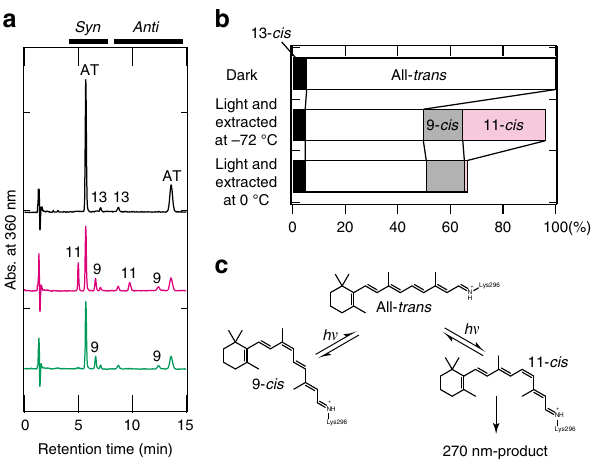
Fig. 2 Retinal con fi gurations in the intermediates produced by irradiation of Opn5L1 at − 72 °C. a HPLC patterns of the retinaloximes extracted from non-irradiated Opn5L1NC sample (black), cooled at − 72 °C in an ethanol/ dry ice bath and irradiated with >500 nm light for 1 min (magenta), and subsequent incubation at 0 °C for 30 min (green). b Calculated compositions of retinal isomers in the samples based on each peak area in the chromatogram from a and the extinction coef fi cients previously reported 55 . Compositions of the retinal isomers of the dark sample (black in a ) were 5.50 and 94.5% for the 13- cis and all- trans , respectively. Those of the sample after >500 nm light irradiation for 1 min and extraction at − 72 ° C (magenta in a ) were 4.86, 45.0, 15.0, and 31.3% for the 13- cis , all- trans , 9- cis and 11- cis , respectively. Those of the sample after >500 nm light irradiation for 1 min at − 72 °C, followed by extraction after incubation at 0 ° C for 30 min (green in a ) were 4.88, 46.1, 14.5, and 1.19% for the 13- cis , all- trans , 9- cis and 11- cis , respectively. c Reaction scheme of the chromophore of Opn5L1NC under irradiation with >500 nm light at − 72 °C. It should be noted that only the 11- cis isomer was not extracted after incubation of the irradiated sample at 0